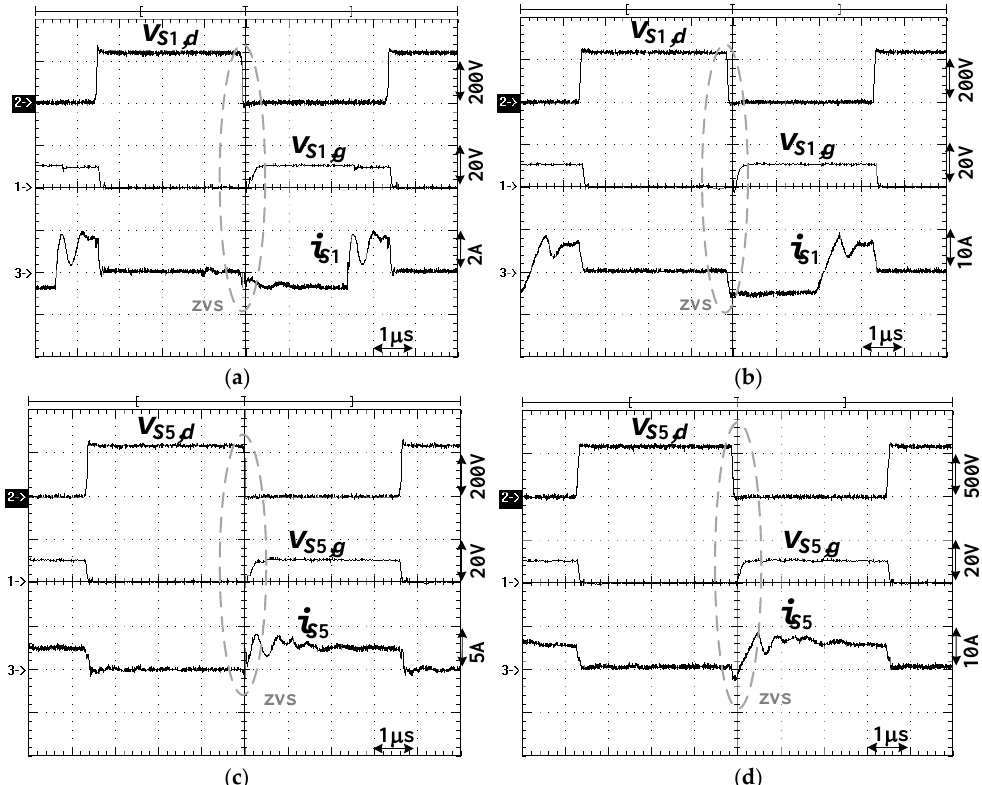
Figure 13. Test waveforms of S 1 and S 5 at V in = 600 V: ( a ) S 1 under 20% load; ( b ) S 1 under 100% load; ( c ) S 5 under 20% load; ( d ) S 5 under 100% load.